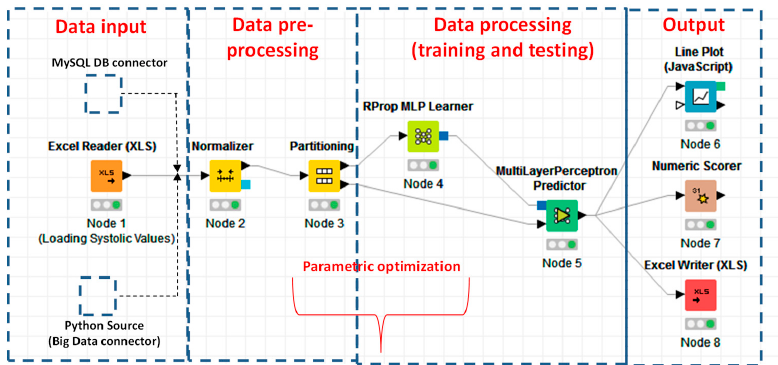
Figure 10. KNIME (Konstanz Information Miner): MLP graphical user interface (GUI) neural network for the prediction of the health status of a patient.